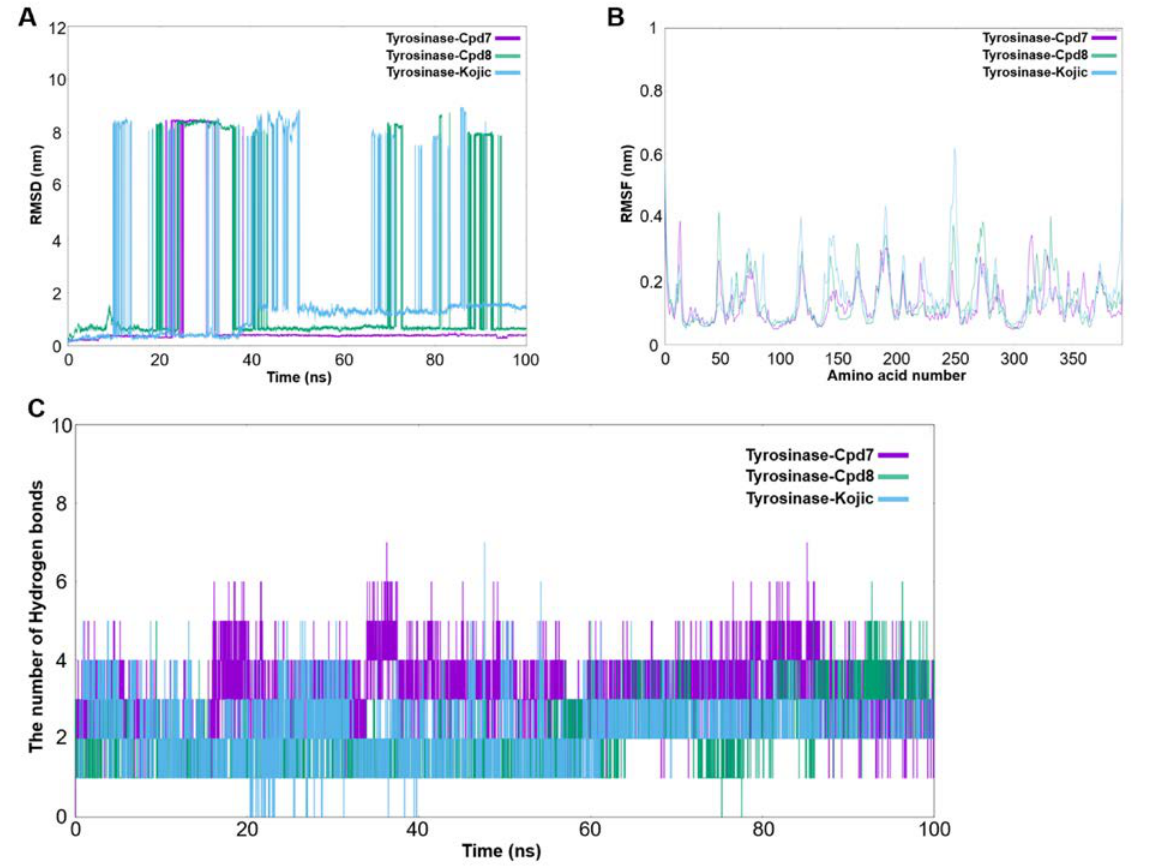
Figure 5. Molecular dynamic (MD) simulation results. ( A ) Root mean square deviation (RMSD) time profiles of BABT derivatives 7 and 8 and kojic acid during 100 ns, ( B ) root mean square fluctuation (RMSF) curve between compounds 7 , 8 , and kojic acid and the amino acid residues (sequence 0–400) of tyrosinase during the MD simulation, and ( C ) the number of hydrogen bonds between compounds 7 , 8 , and kojic acid and the amino acid residues of tyrosinase during 100 ns.